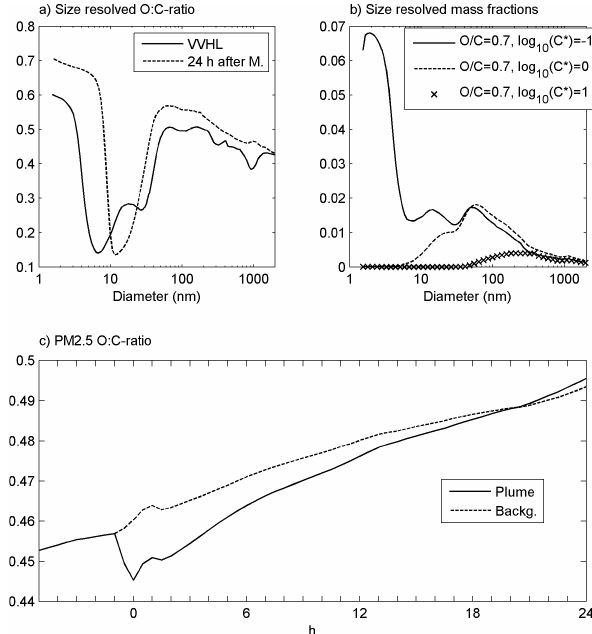
Fig. 8. Modeled organic aerosol particle properties with the 2-D- VBS model in ADCHEM. (a) size resolved O:C-ratio at Vavihill and 24h downwind of Malm¨o, (b) size resolved organic aerosol mass fractions at Vavihill for three 2-D-VBS compounds with dif- ferent volatility ( C ∗ ) but equal O:C-ratio and (c) Average PM 2 . 5 O:C-ratio inside and outside the urban plume downwind of